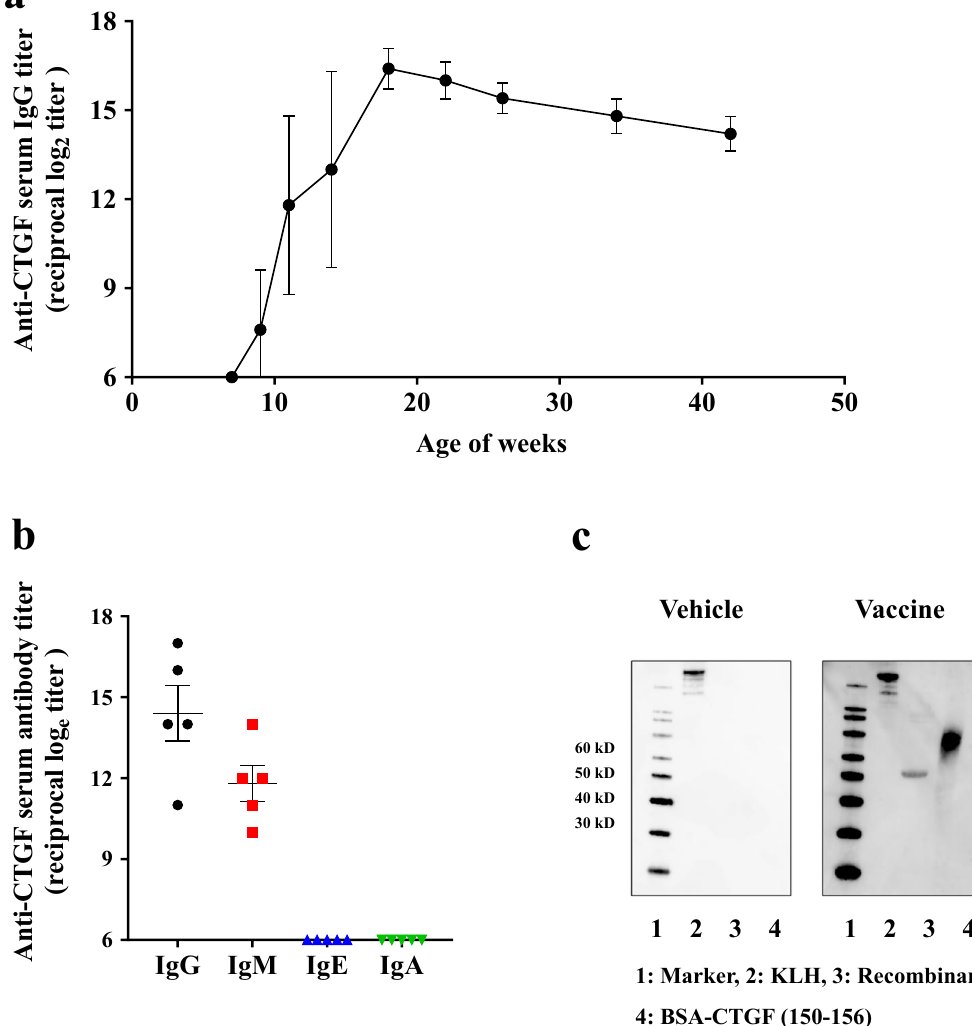
Figure 1. CTGF vaccination elicits antigen-specific antibodies in mice. Male C57BL/6 J mice were inoculated with the CTGF vaccine at 6, 8, and 10 weeks of age, and serum antigen-specific antibody titers were determined by using ELISA ( n = 5). ( a ) Variation in serum IgG antibodies against the antigen was examined from 7 to 42 weeks of age. The antibody titer rapidly increased after the third inoculation, reaching a peak at 18 weeks of age. After that, it was maintained at a relatively high level until 32 weeks after the third inoculation. ( b ) Serum immunoglobulin isotypes of antibodies against the antigen in mice immunized with the CTGF vaccine were evaluated at 11 weeks of age. IgG antibodies were dominant although IgM antibodies were also detected at a certain level. IgE and IgA antibodies were scarce. ( c ) Western blotting analyses showed that serum from mice immunized with the CTGF vaccine specifically bound to not only the vaccine antigen but also to rhCTGF. In contrast, serum from mice inoculated with the KLH vehicle did not demonstrate binding to CTGF vaccine antigen or rhCTGF. Error bars show mean ± SEM.